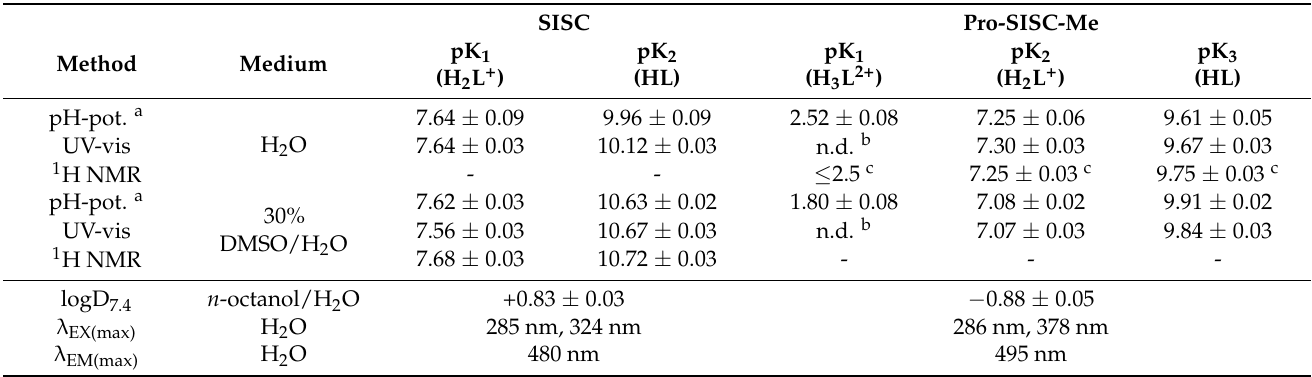
Table 1. pK a values of SISC and Pro-SISC-Me determined by various methods in water and in 30% ( v / v ) DMSO/H 2 O, their n -octanol/water distribution coefficients (logD 7 . 4 ) and fluorescence λ λ EX (max) and EM (max) values at pH 7.4 in water. HL is the neutral form of the ligands. ( T = 25 I = 0.10 M (KCl)).